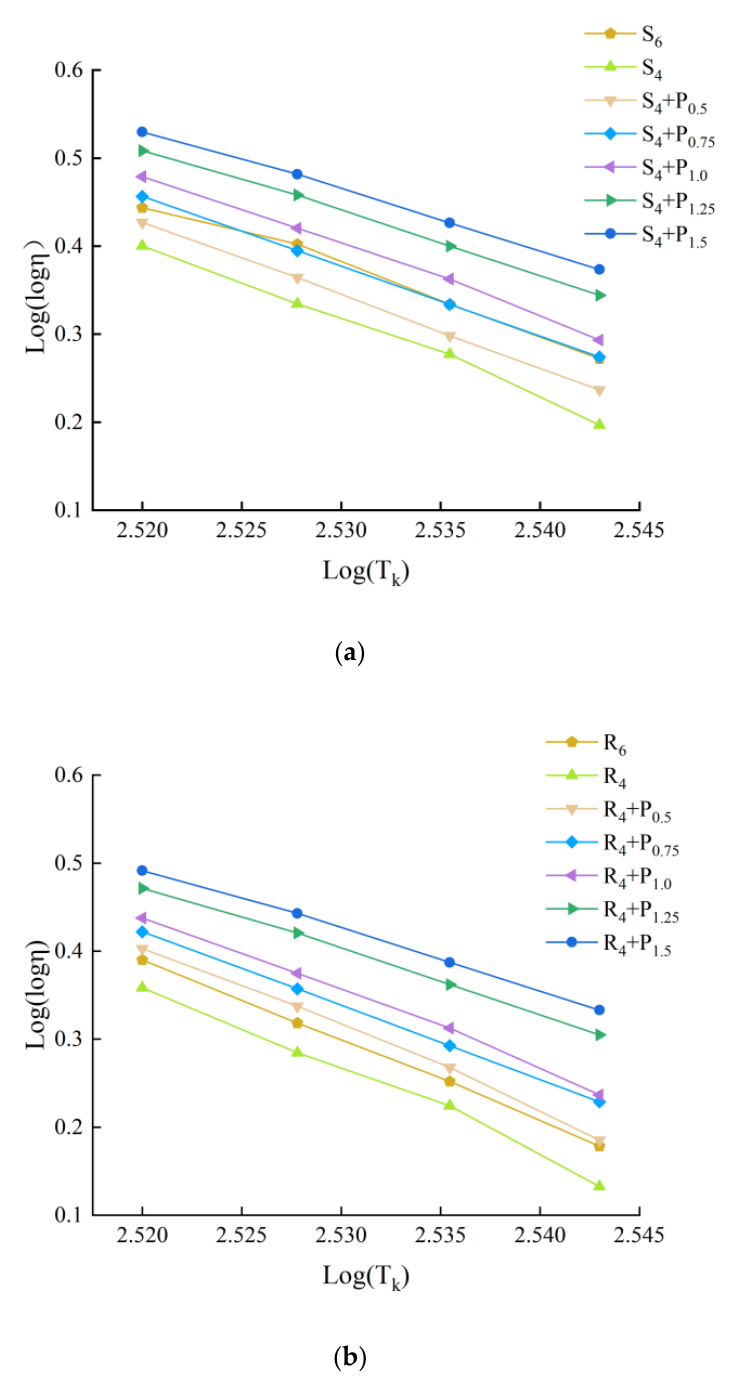
Figure 20. Double logarithm regression viscosity temperature curve of LH – 90# asphalt: ( a ) PPA – SBS compound ratio; ( b ) PPA – SBR compound ratio.